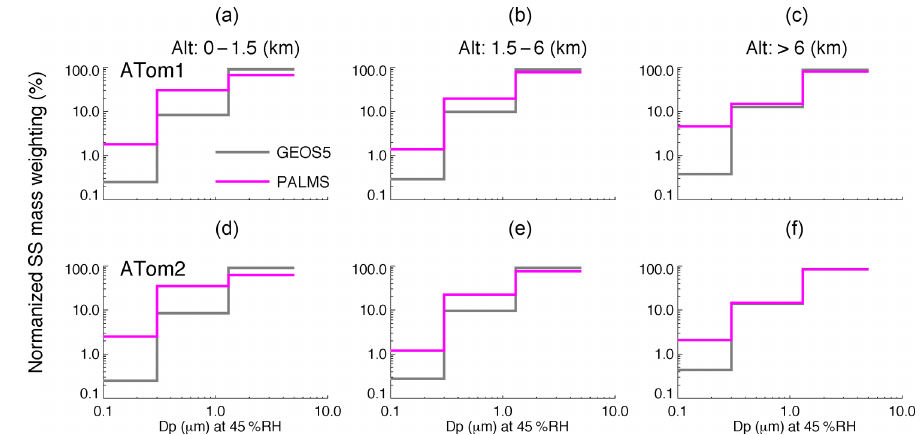
Figure 6. Percentage distribution of sea salt mass over the first three bins, normalized to the total sea salt with a particle wet diameter up to ∼ 5µm at RH 45%. The normalized SS mass-weighting distribution is sorted over three vertical layers and for ATom1 (a–c) and ATom2 (d–f) , respectively.